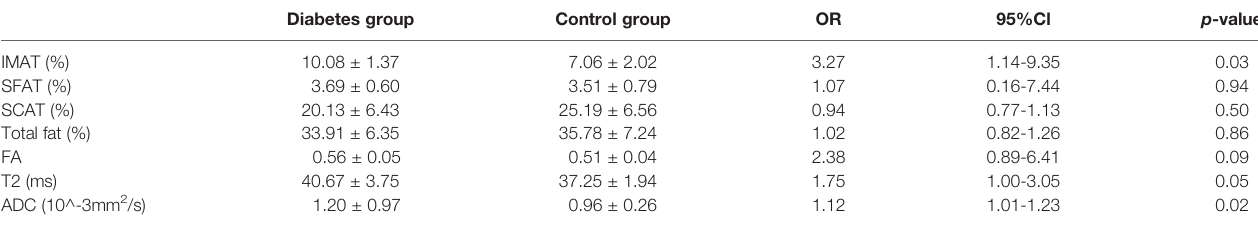
TABLE 3 | Comparison of muscle magnetic resonance parameters and muscle fat components in diabetes group (N = 12) and control group (N = 12). Diabetes group